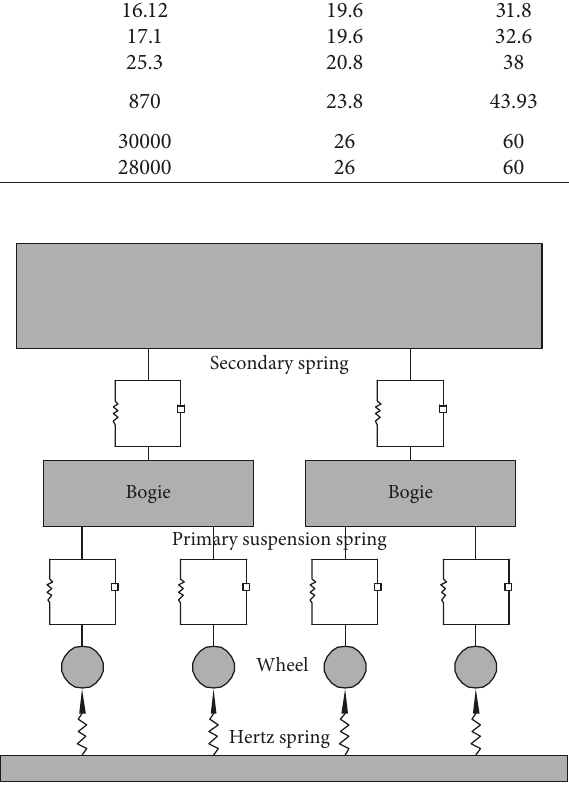
Figure 6: The simplified model of the Metro train [19].